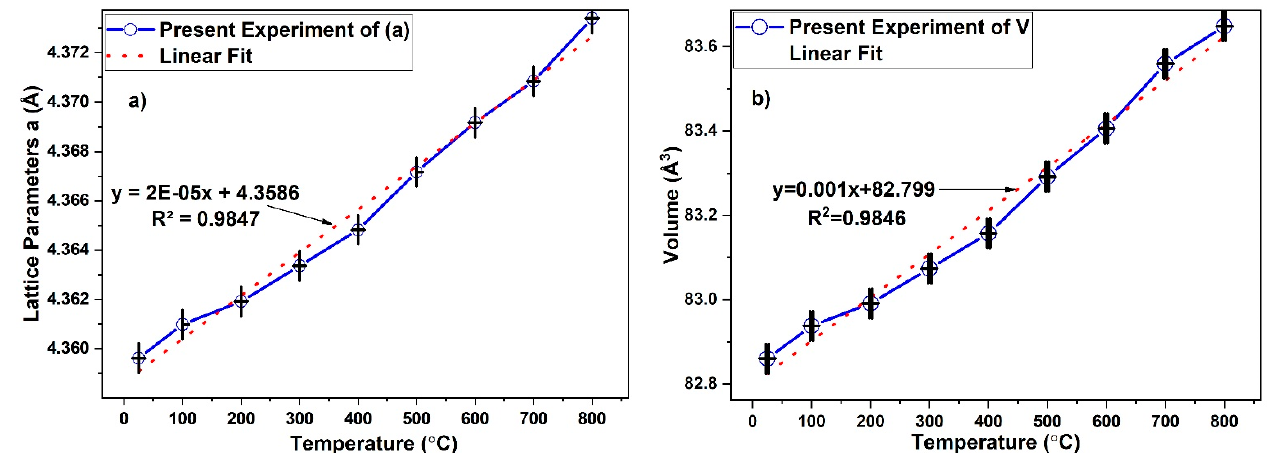
Figure 6. Crystalline structure of 3C-SiC: ( a ) lattice parameters and ( b ) unit cell volume. The scattered data of The Williamson-Hall (W-H) method are analysed in Figure 7. The (W-H) provided the macrostrain and inverse of the plot intercept estimate the particle size. The average particle size estimated from (W-H) at 25°C is 0.00698 and increase as the temperature increased due to dilation of the crystal lattice as confirmed in Figure 6a,b. However, this trend is agreed with literature [41]. The lattice strain of 25°C, 100°C and 300°C is fluctuation from 2.96 × 10 (cid:2879)(cid:2873) , 7.33 × 10 (cid:2879)(cid:2872) and 1.01 × 10 (cid:2879)(cid:2871) , respectively. How- ever, from the temperature range of 400–800 °C, the lattice strain observed stable due to the crystalline structure stability.